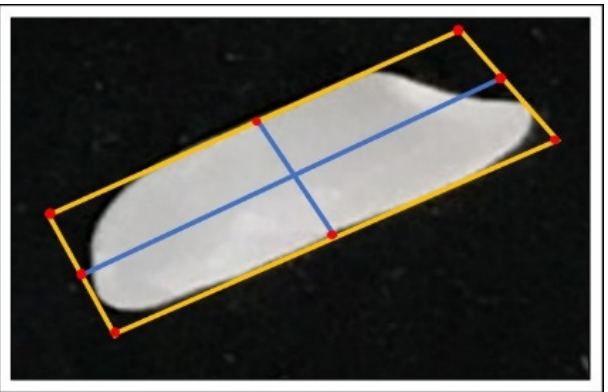
Figure 6. Each rice kernel is labelled with their boundaries. The boundaries highlighted in orange after the contours were detected successfully.